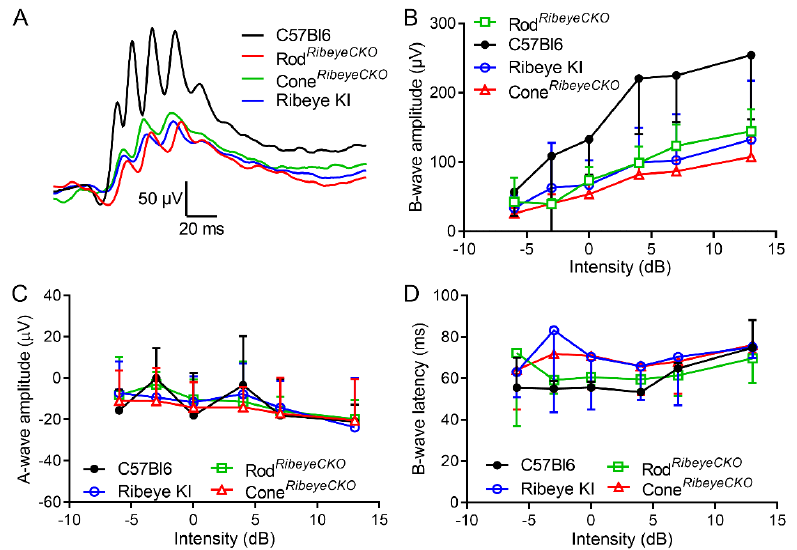
Figure 6. Photopic ERG b-waves were reduced equally in the cone Ribeye CKO , rod Ribeye CKO , and Ribeye KI retinas. ( A ) Example waveforms. ( B ) B-wave amplitude as a function of flash intensity measured in the C57Bl6J ( n = 5 mice), cone Ribeye CKO ( n = 5), rod Ribeye CKO ( n = 5), and Ribeye KI retinas ( n = 4). ( C ) A-wave amplitude as a function of intensity. ( D ) B-wave latency vs.